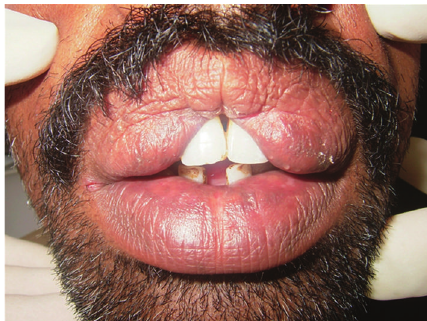
Figure 2: Frontal view of double lip.